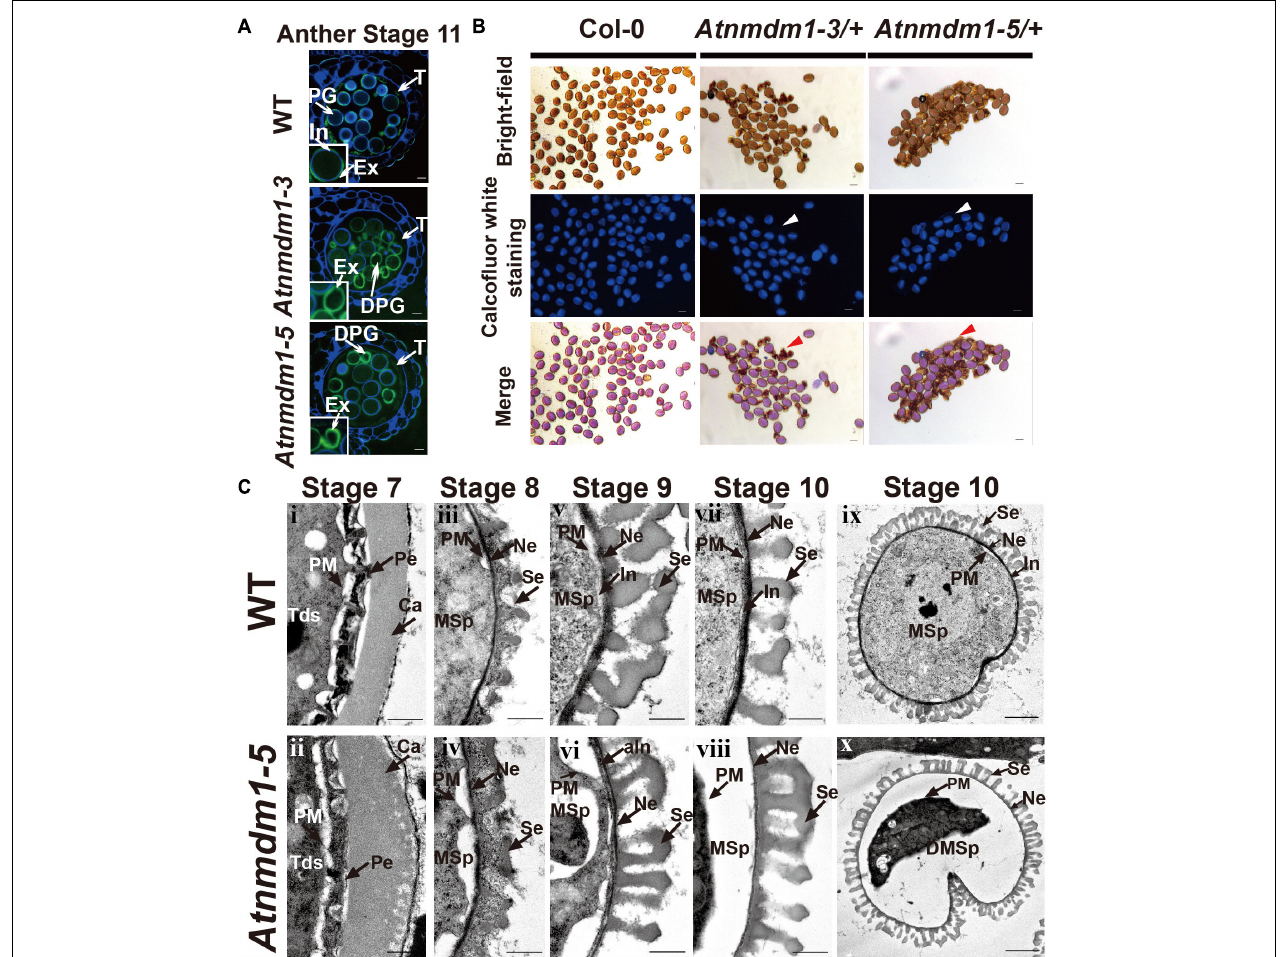
FIGURE 5 | The development of the intine layer is abnormal in AtNMDM1 + / − mutant s . (A) Cytochemical staining of semi-thin sections of wild type and AtNMDM1 + / − mutants. All wild-type pollens showed a blue fluorescent ring of the intine layer while Atnmdm1-3 and Atnmdm1-5 pollen showed almost an absence of the intine layer. DPG, degenerated pollen grain; In, intine; Ex, exine; T, tapetum. Bar = 10 µ m. (B) Calcofluor white staining of mature pollen in Arabidopsis. The pollen in the Col-0 and Atnmdm1-3/ +, Atnmdm1-5/ + plants are shown. Arrowheads indicate the aborted pollen grains with no detectable fluorescence. Bar = 20 µ m. (C) Transmission electron microscopy (TEM) observation of wild type and Atnmdm1-5 pollen. TEM images of pollen walls at anther stages 7 and 8 showed that microspore layers were quite normal in the pollens of the wild type (i, iii) and Atnmdm1-5 (ii, iv); (v, vi), stage 9, showing intine was abnormal in Atnmdm1-5 pollen, compared to the wild type pollen; (vii, viii), stage 10, showing that the intine had almost disappeared in Atnmdm1-5 pollen; (ix), stage 10, the content of the microspore in the wild type; (x), stage 10, showing the degenerated and condensed content in Atnmdm1-5 microspores. Tds, tetrads; Ca, callose wall; PM, plasma membrane; Pe, primexine; MSp, microspore; Ne, nexine; Se, sexine; aIn, abnormal intine; DMsp, degenerated microspore. i–viii, bar = 500 nm; and, bar = 2 µ m.